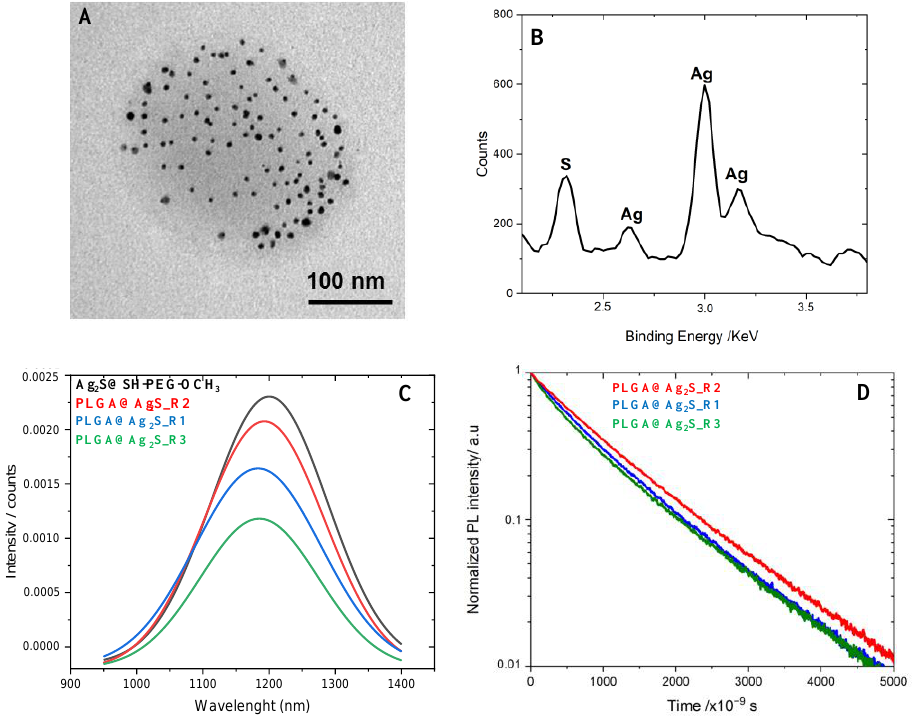
Figure 3. ( A , B ) Energy-dispersive X-ray spectroscopy spectra of the included PLGA@Ag 2 S NPS showing the Ag and S regions. ( C ) PL emission spectra and ( D ) PL decay curves for Ag 2 S@SH-PEG-OCH 3 NPs (black line), PLGA@Ag 2 S_R1 (blue line), PLGA@Ag 2 S_R2 (red line), and PLGA@Ag 2 S_R3 green